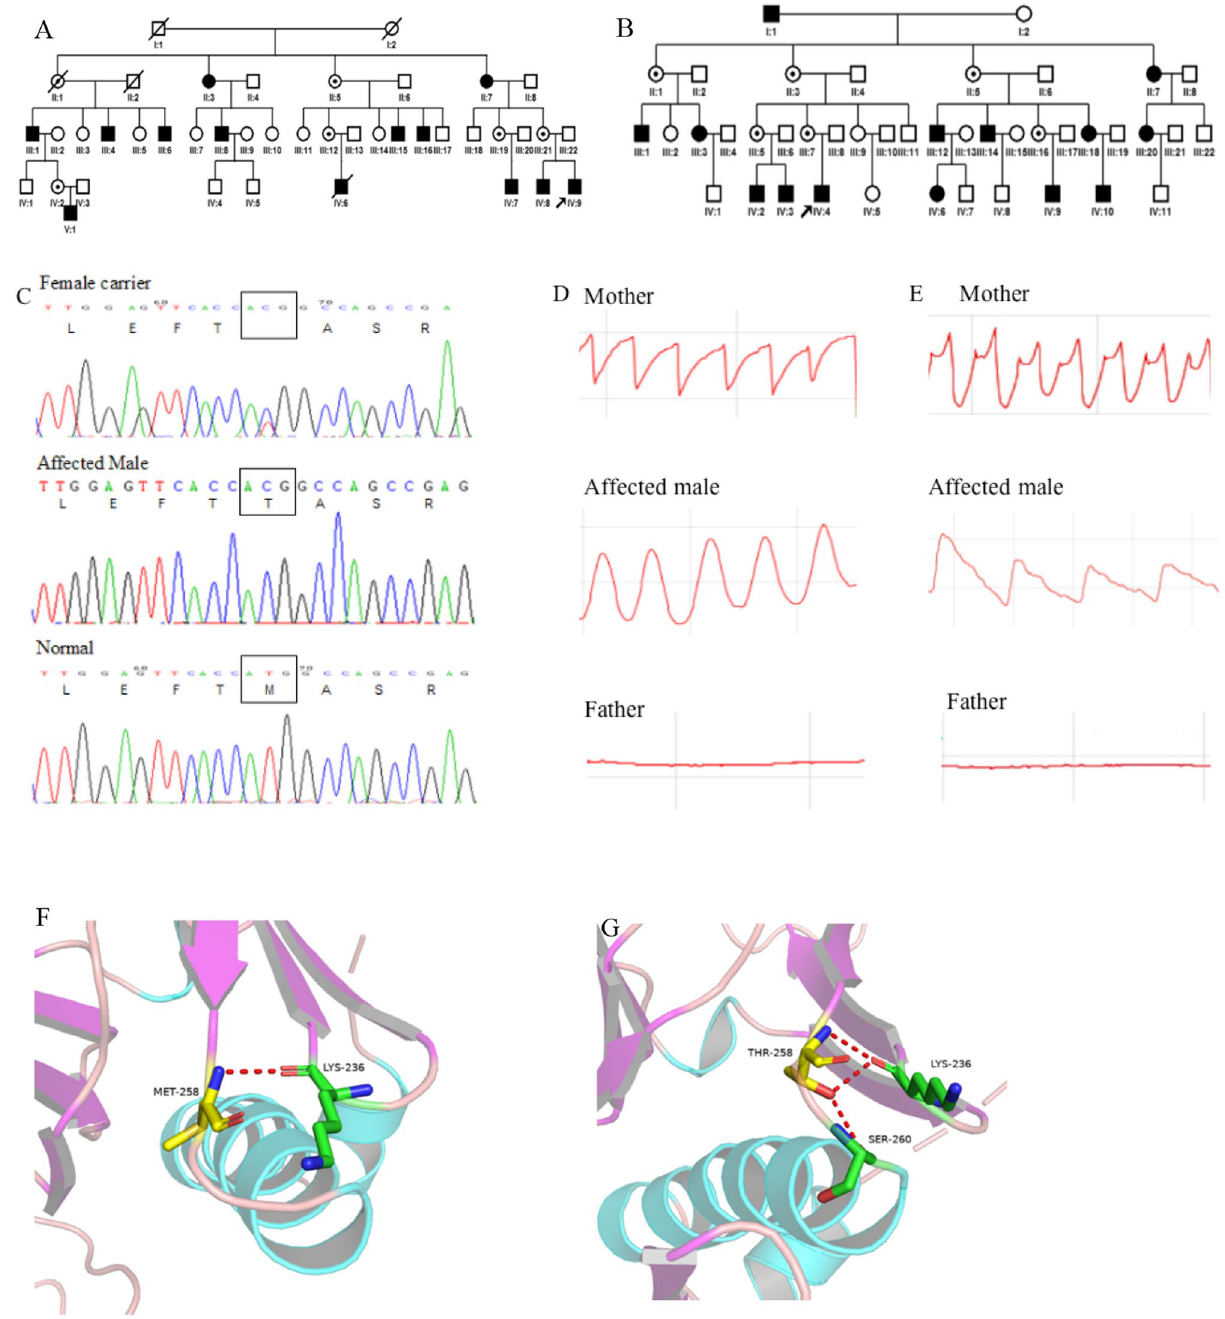
Figure 3. FRMD7 mutation and waveforms recorded in two families. The probands in families A and B (denoted by the black arrows) carried the same mutation of c.773 T > C (p.M258T) in exon 9 ( C ). Nystagmus was recorded as horizontal pendular waveforms from the proband ( D , middle panel), and as decelerating exponential slow phase jerk waveforms from his mother ( D , upper panel) in the Family A . As a control, his father had normal eye movement recordings ( D , lower panel). The proband in Family B showed horizontal decelerating exponential slow phase jerk waveforms ( E , middle panel), and his mother had horizontal dual jerk waveforms ( E , upper panel), compared with his father ( E , lower panel). A 3-D model construction showed a wild-type nonpolar amino acid of Methionine ( F ) was replaced by a charged and polar amino acid of Threonine ( G ), which would damage the stability of the protein structure and